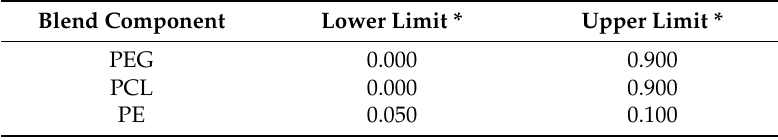
Table 6. Variation ranges in experimental design for polyurethanes synthesis.